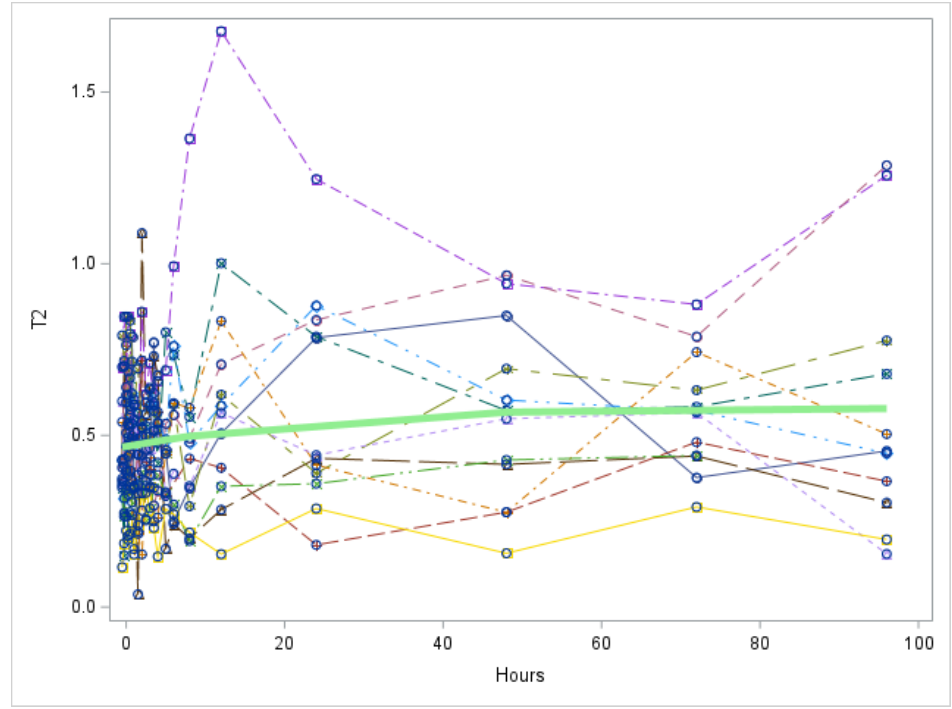
Figure A4. Study 1: 3,5-T2 trend over all hours after LT3 dose (Each individual line represents a participant. The green line represents the mean values for all participants). T2 = 3,5-T2 concentration in nmol/L. There is no significant change in 3,5-T2 over time, p value =